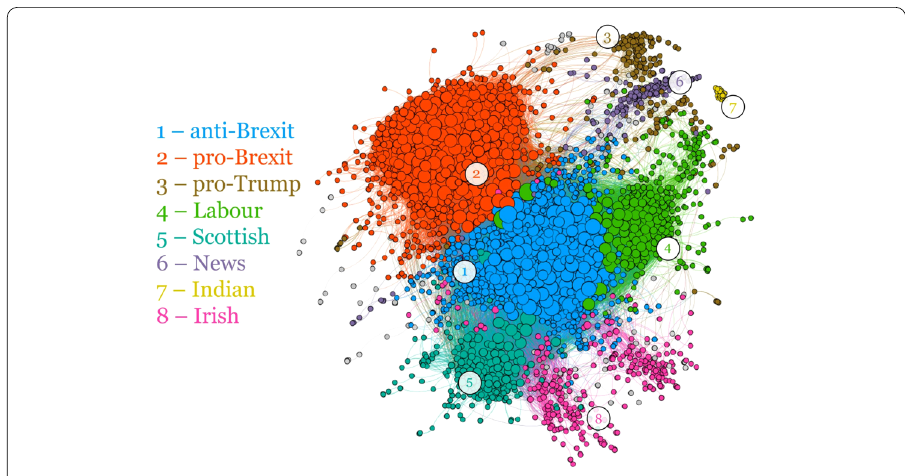
Figure 5 Projected network of the verified users. The eight biggest communities have been highlighted and their composition is further explained in Table